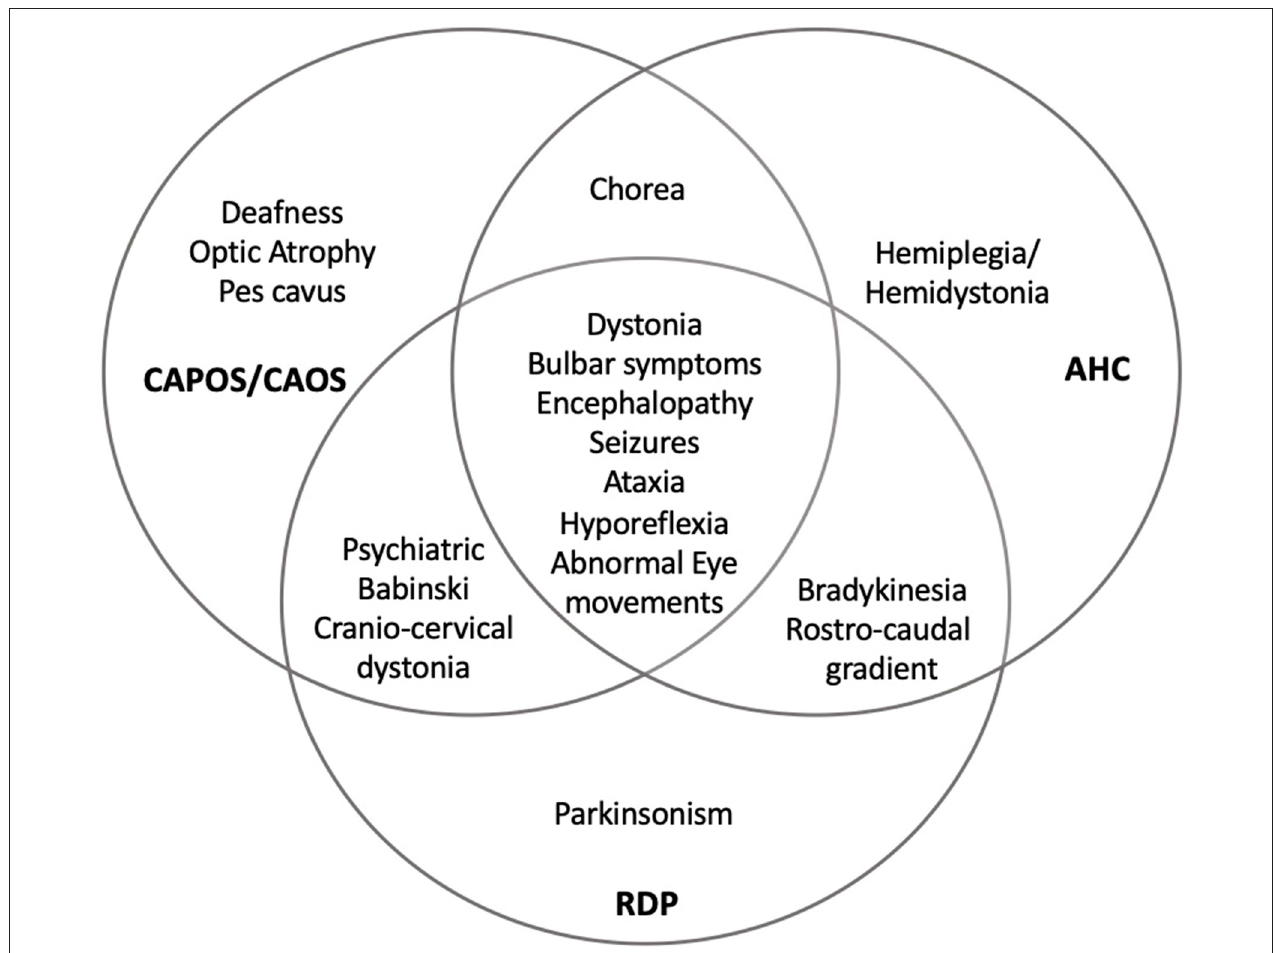
FIGURE 1 | Overlapping of ATP1A3-related disorders. RDP, rapid-onset dystonia-parkinsonism; AHC, alternating hemiplegia of childhood; CAPOS, cerebellar ataxia, areflexia, pes cavus, optic atrophy, and sensorineural hearing loss; CAOS, cerebellar ataxia, areflexia, optic atrophy, and sensorineural hearing loss. With permission from Salles and Fernandez, reference (